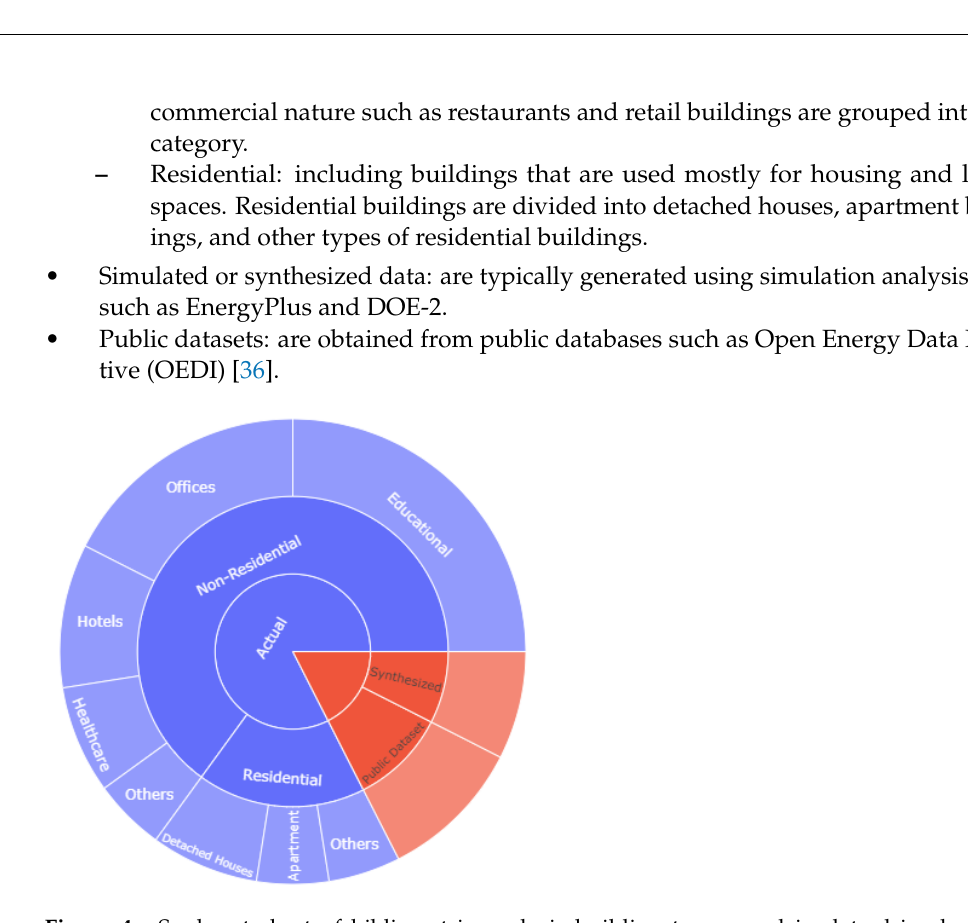
Figure 4. Sunburst chart of bibliometric analysis building types used in data-drive building energy